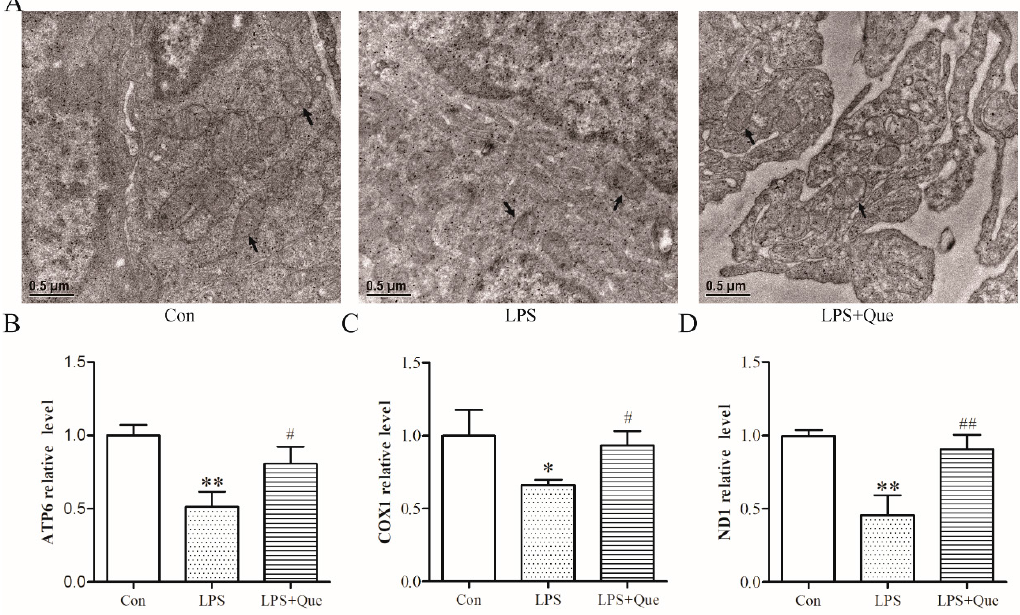
Figure 2. The effects of quercetin on jejunal mitochondria of broiler chickens. ( A ) Mitochondria from different groups were observed by electron microscopy. The mtDNA relative expression levels of ATP synthase F0 subunit 6 (ATP-6) ( B ), cytochrome c oxidase subunit 1 (COX1) ( C ), and NADH dehydrogenase subunit 1 (ND1) ( D ). Values are shown as the mean ± SEM. ** p < 0.01 or * p < 0.05 compared with the Con group. ## p < 0.01 or # p < 0.05 compared with the LPS group.